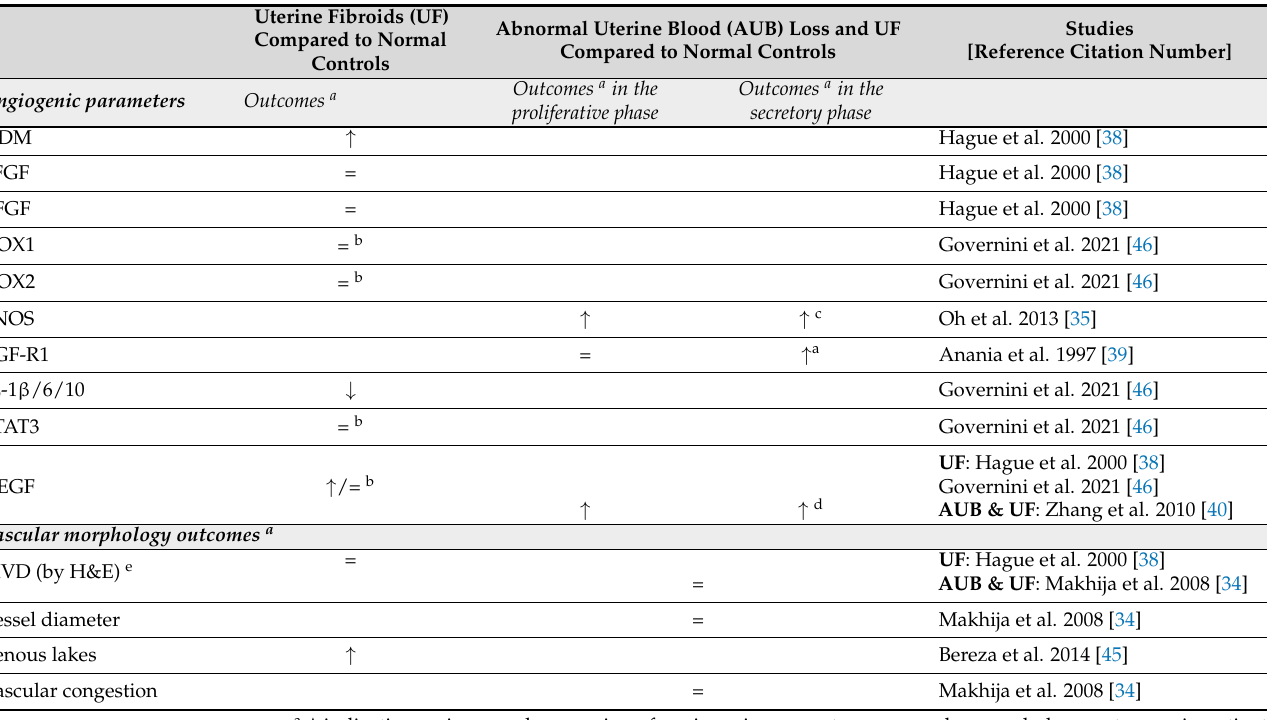
Table 4. Outcomes of the included articles regarding angiogenesis in the endometrium of patients with uterine fibroids (UF) compared to normal controls and UF with abnormal uterine blood loss (AUB) compared with normal